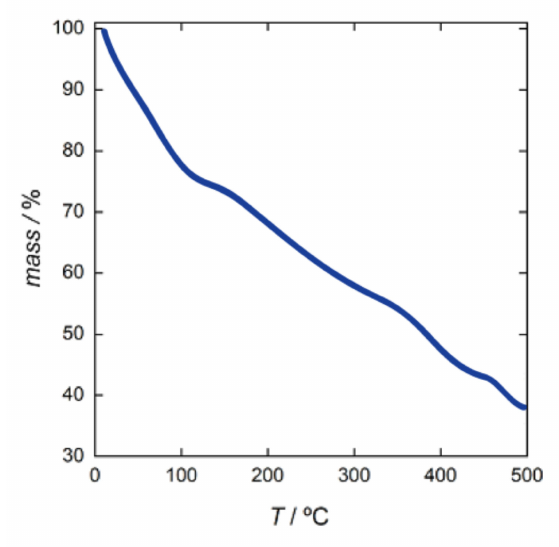
Figure 5. TGA of CMP MOF 1 under dry N 2